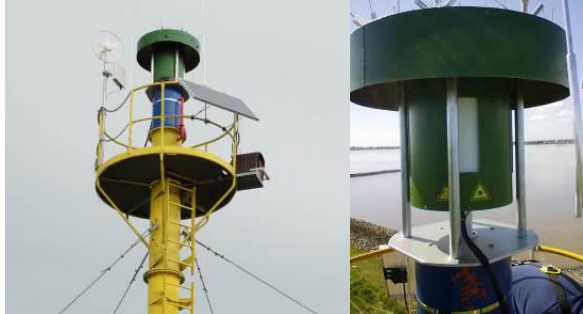
Figure 4. Complete system setup with case, solar panel and wind wheel (left), casing for the scanner on top of the platform